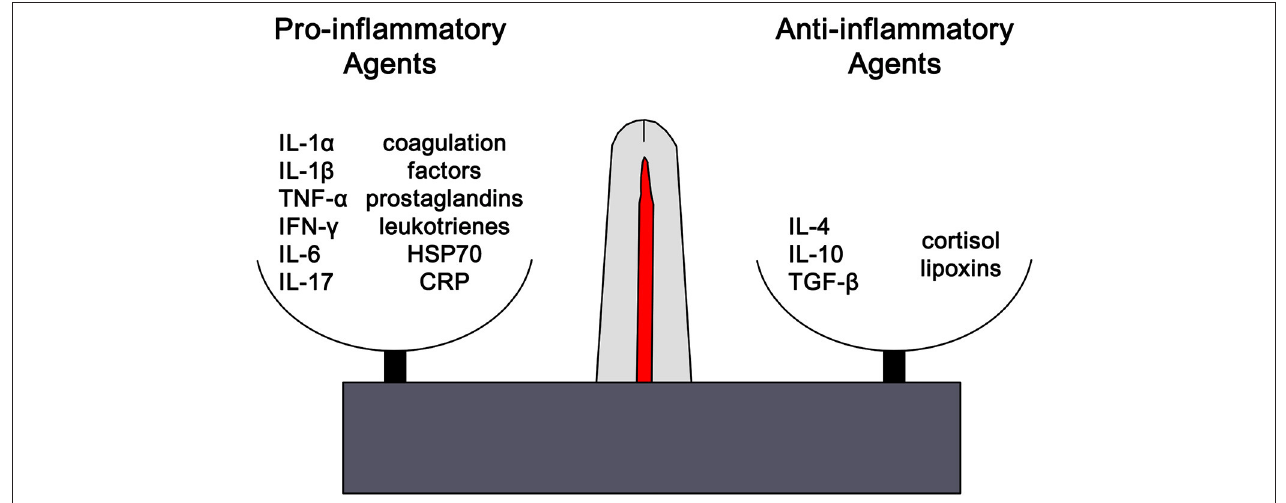
FIGURE 1 | The outcome of any inflammatory response is dictated by the balance between pro-inflammatory and anti-inflammatory factors. Each of these opposing pathways is mediated by different cytokine and hormonal influences. For example, inflammation is favored by IL-1 β , IL-6, and TNF- α , whilst being inhibited by IL-10 and TGF- β . The distinctions are not absolute and can vary based on the context. However, excess or chronic inflammation is seen in conditions where the mechanisms mediating homeostasis and balance between the two pathways become compromised. IL1 α , interleukin-1alpha; IL-1 β , interleukin-1beta; TNF- α , tumor necrosis factor-1alpha; IFN- γ , interferon-gamma; IL-6, interleukin-6; IL-17, interleukin-17; HSP70, heat shock protein 70, CRP, C-reactive protein; IL-4, interleukin-4, IL-1, interleukin-1, TGF- β , transforming growth factor-beta.